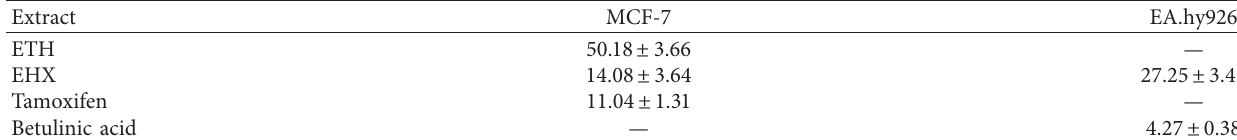
Table 2: IC 50 values ( μ g/mL) by using MTT